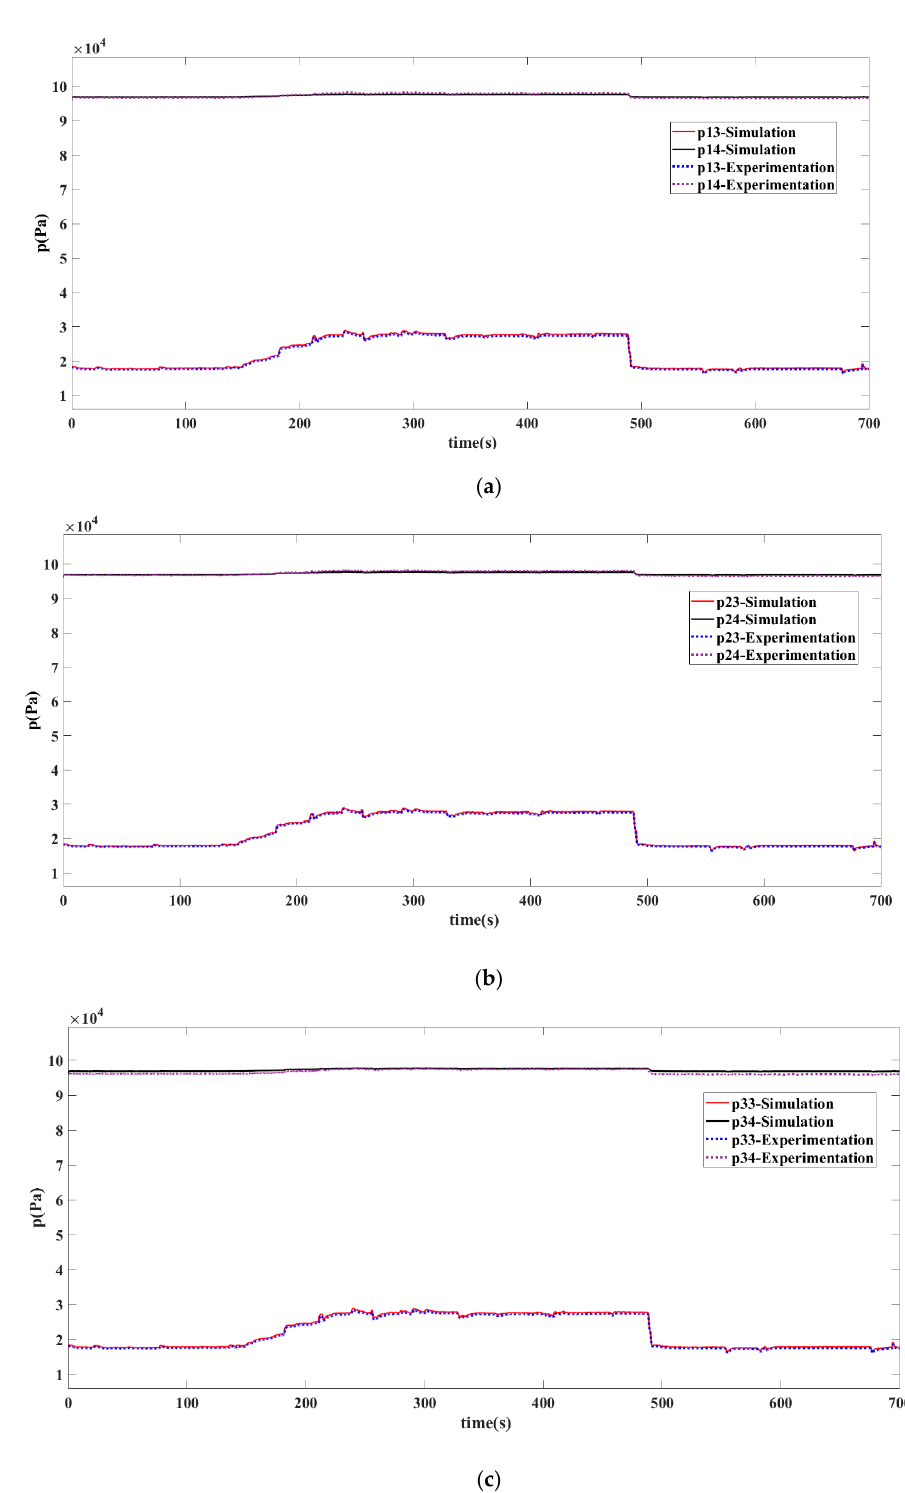
Figure 5. Comparison of simulation and experimental results on compressor pressure. ( a ) Results of compression subsystem 1, ( b ) results of compression subsystem 2, ( c ) results of compression subsystem 3.